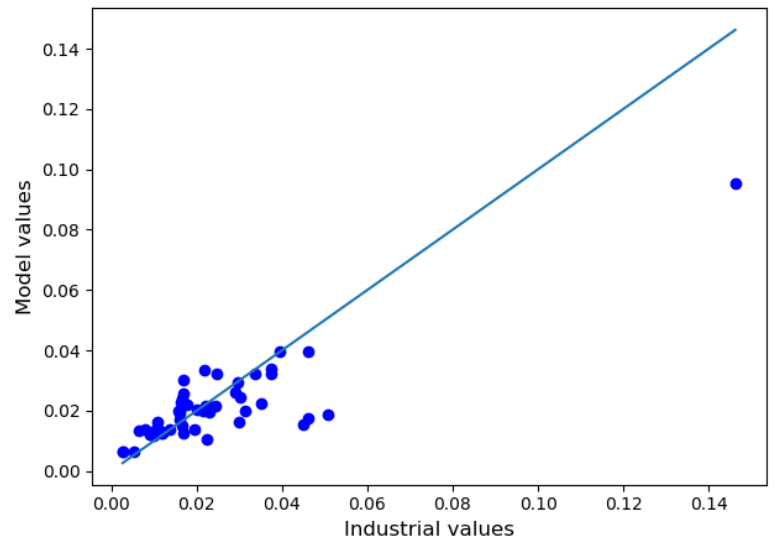
Figure 3. Comparison of the model-predicted corrosion rates and the measured values.